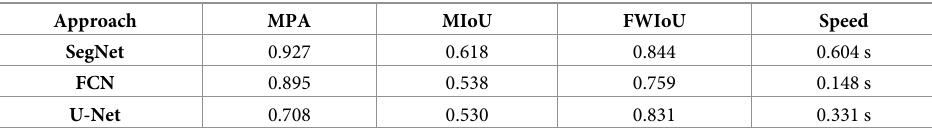
Table 3. Results of SegNet, FCN and U-Net.